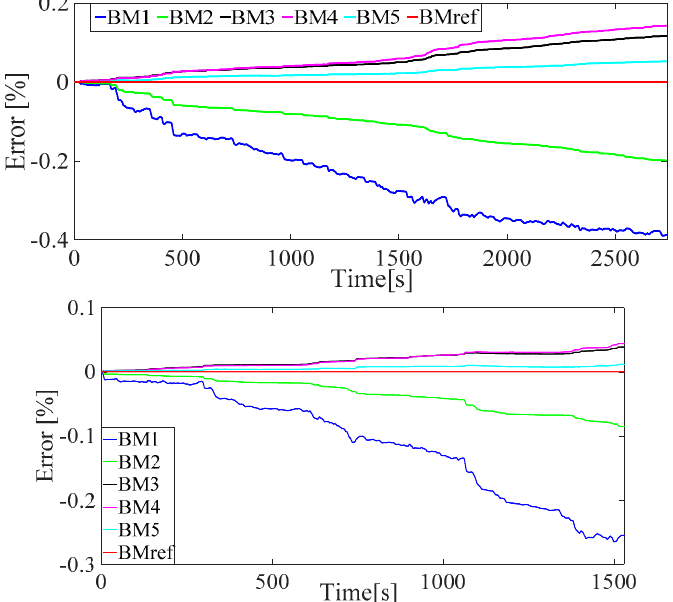
Figure 7. Error between the SoC computed by the model predictive control (MPC) model and the reference vehicle during two Urba n Dynamometer Driving Schedule (UDDS, up ) and Highway Fuel Economy Test (HWFET, down ) drive cycles.